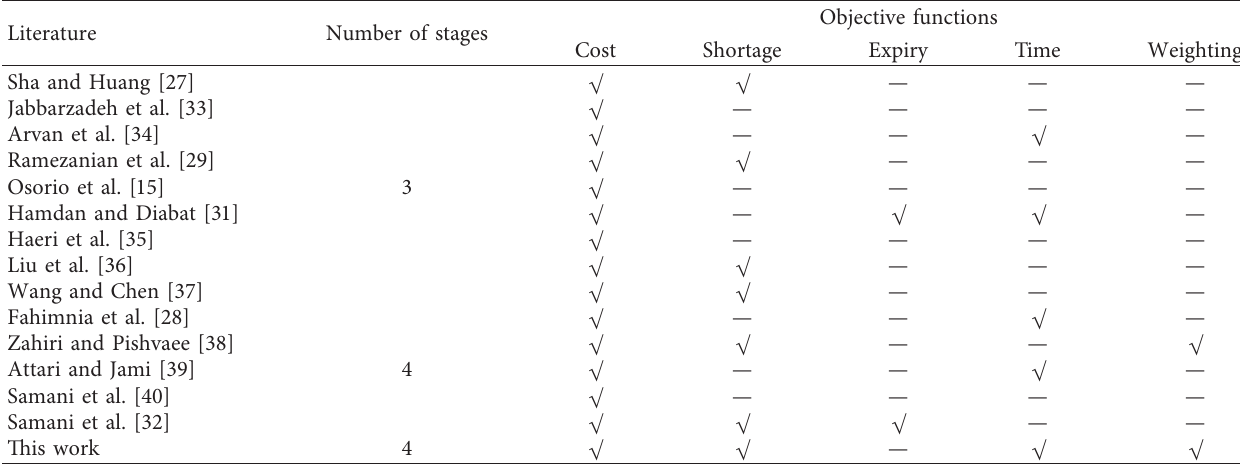
Table 2: Objective functions in some key literature.